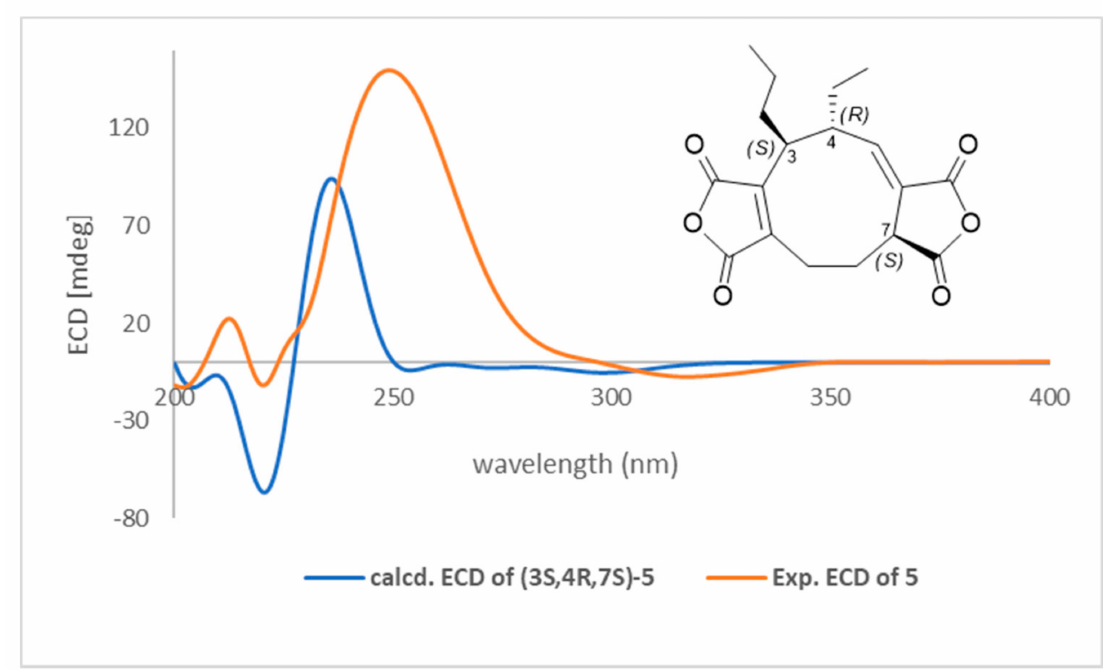
Figure 3. ECD spectra of compound 5 . Experimental and TDDFT calculated ECD spectra of compound 5 at CAM-B3LYP/6- 311++G(d,p) level in methanol